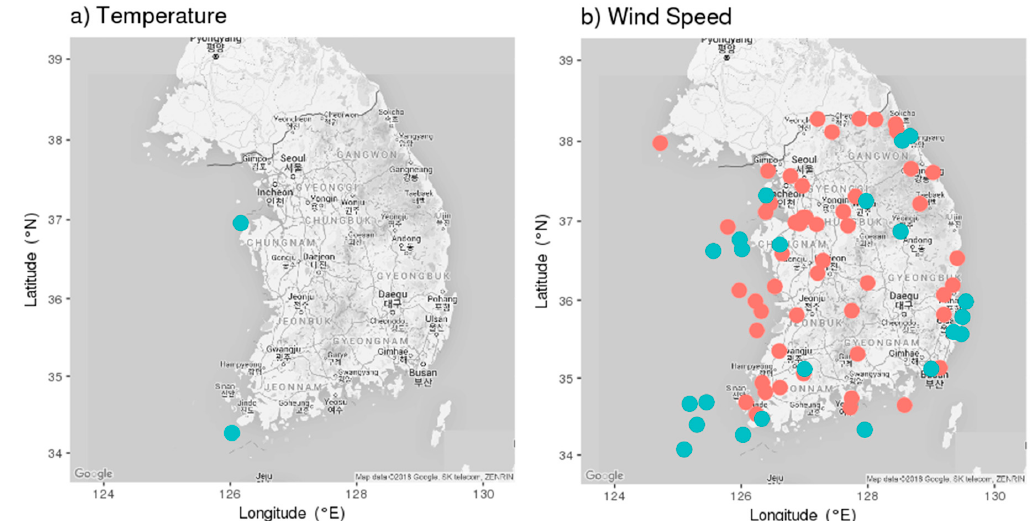
Figure 4. Observation sites with prediction powers >1.2 for ( a ) temperature and ( b ) wind speed in the 69–91-h (blue) and 261–283-h (red) ranges. 69–91 h (blue) and 261–283 h (red)